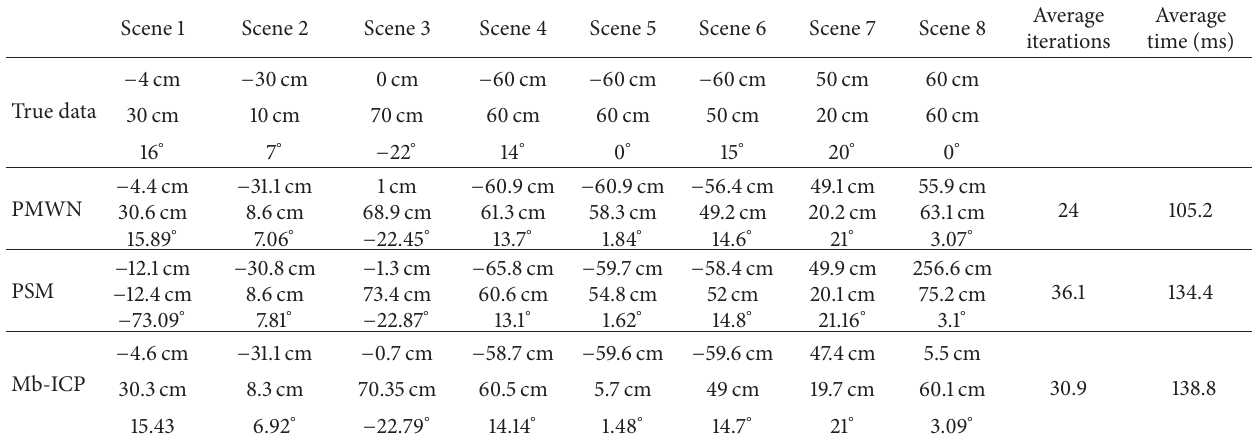
Table 2: Results of the average pose estimation using the large step